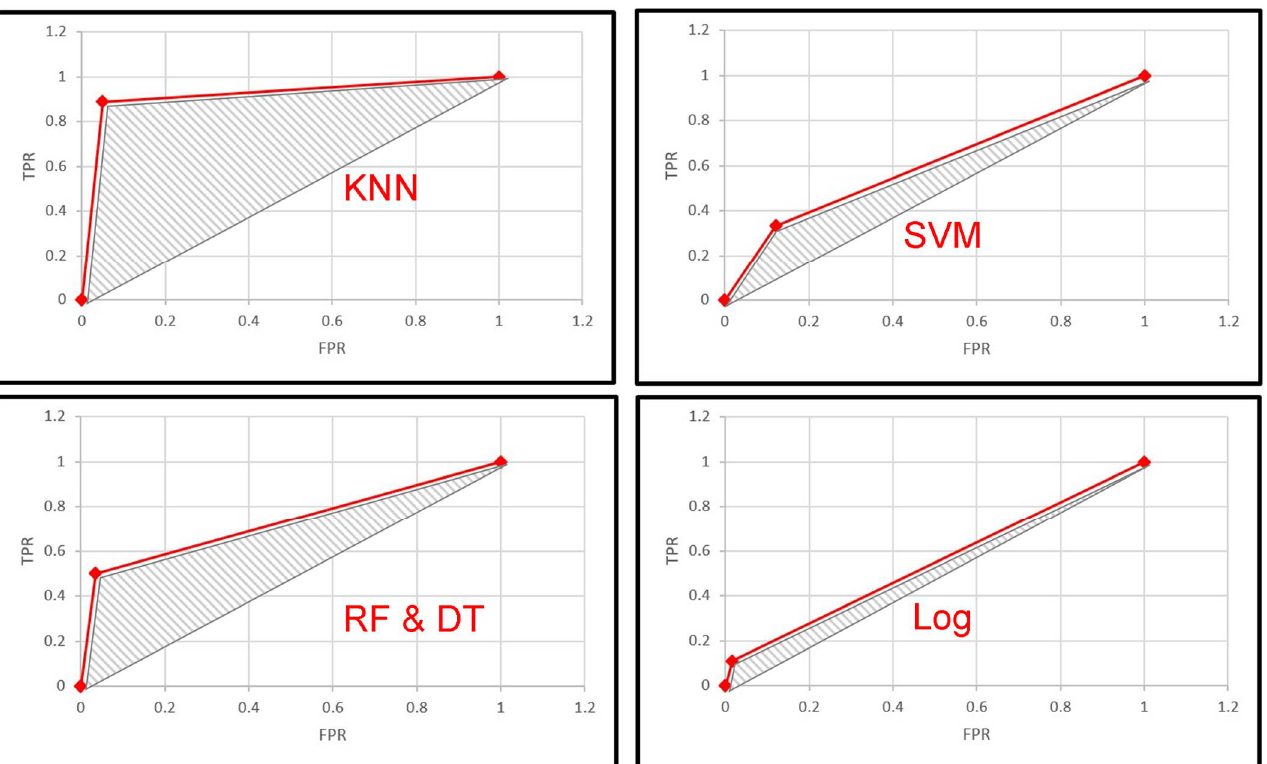
Figure 7. Comparative performance results of the multi-label task selection algorithm (Algorithm 1) using the AUC-ROC metric (KNN, SVM, RF, DT, and LogR).